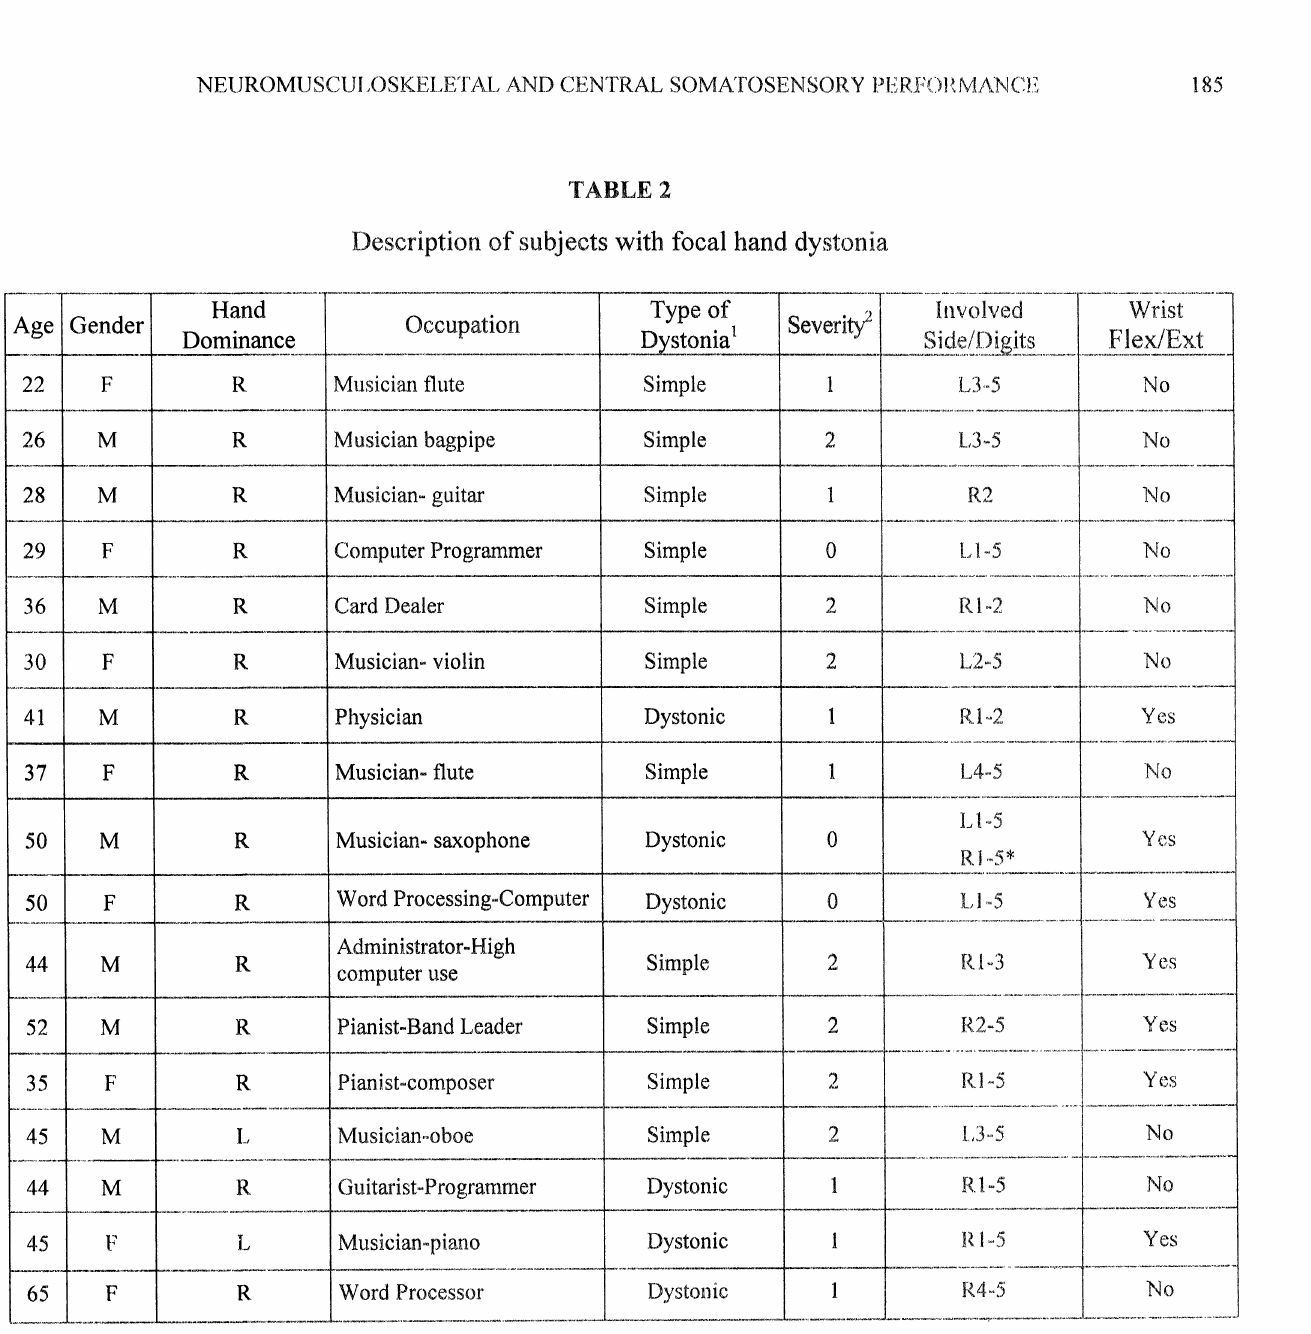
Description of subjects with focal hand